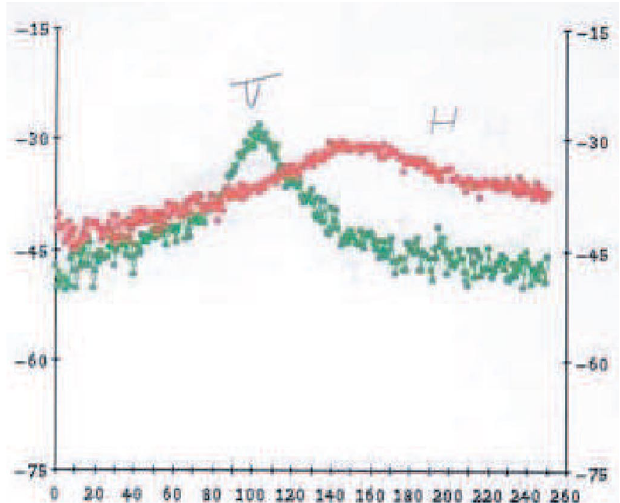
FIG. 65. (Color) Vertical (green) and horizontal (red) tune spec- trum detected at the KEKB LER in 2000 or 2001, with solenoids on, reducing electron density near the beam; the vertical tune spread is much narrower than with solenoids off (compare Fig. 64)